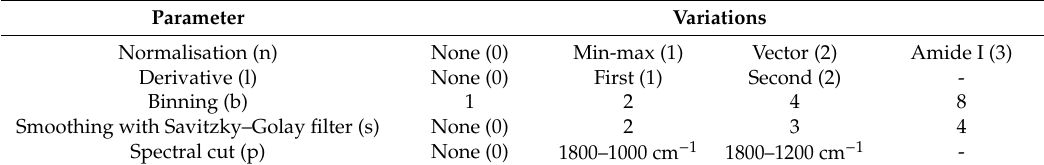
Table 2. Pre-processing parameters examined in machine learning grid search.